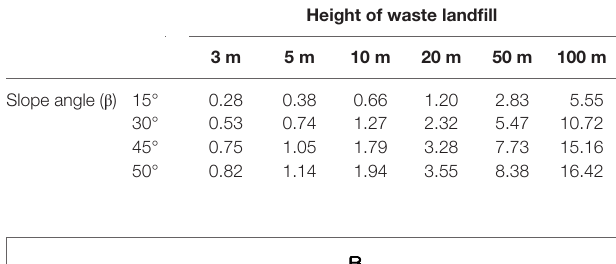
FigUre 4 | schematic diagram of acting loads in waste landfills